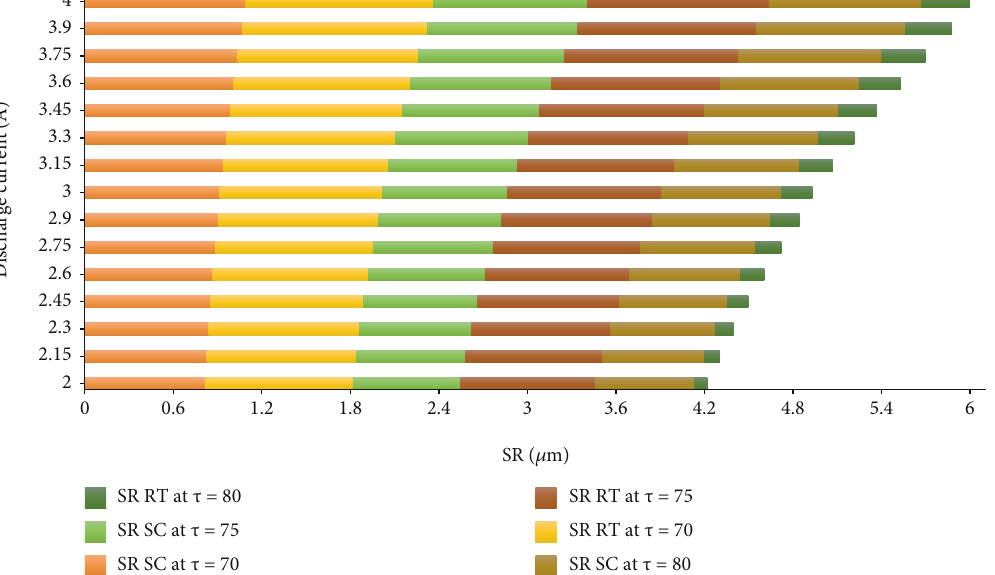
= 150microseconds . on